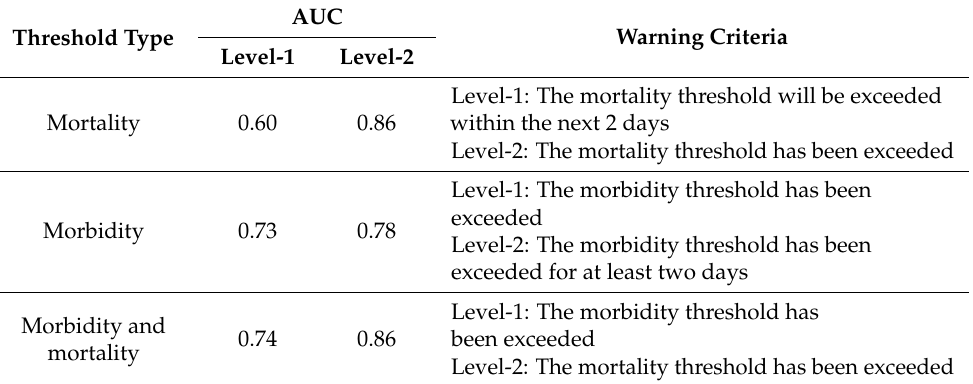
Table 3. Evaluation result using AUC of heatwave early warning by threshold